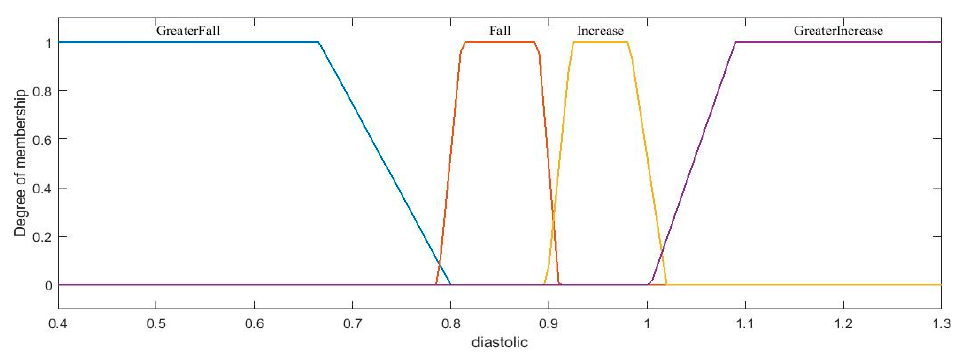
Figure 13. Diastolic quotient input.